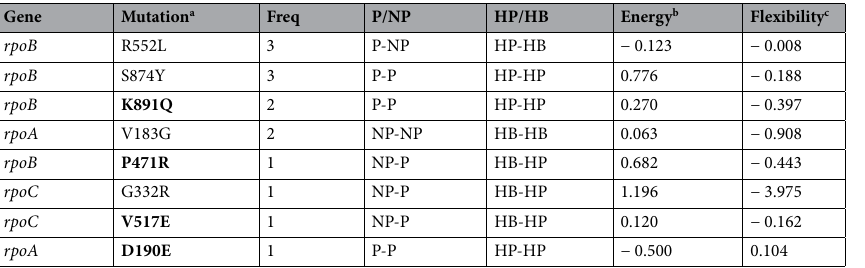
Table 4. Protein structure stability and flexibility effects for low frequency mutations. Low frequency mutations from Table 2, where the number of samples with that mutation in the 35 k dataset was < 300. a Mutation bolded if potentially unreported; P polar, NP non-polar, HP hydrophilic, HB hydrophobic. b Total energy (ΔΔG: kcal/mol), where +ve values are stabilizing and −ve values are destabilizing. c ΔΔSVib ENCoM